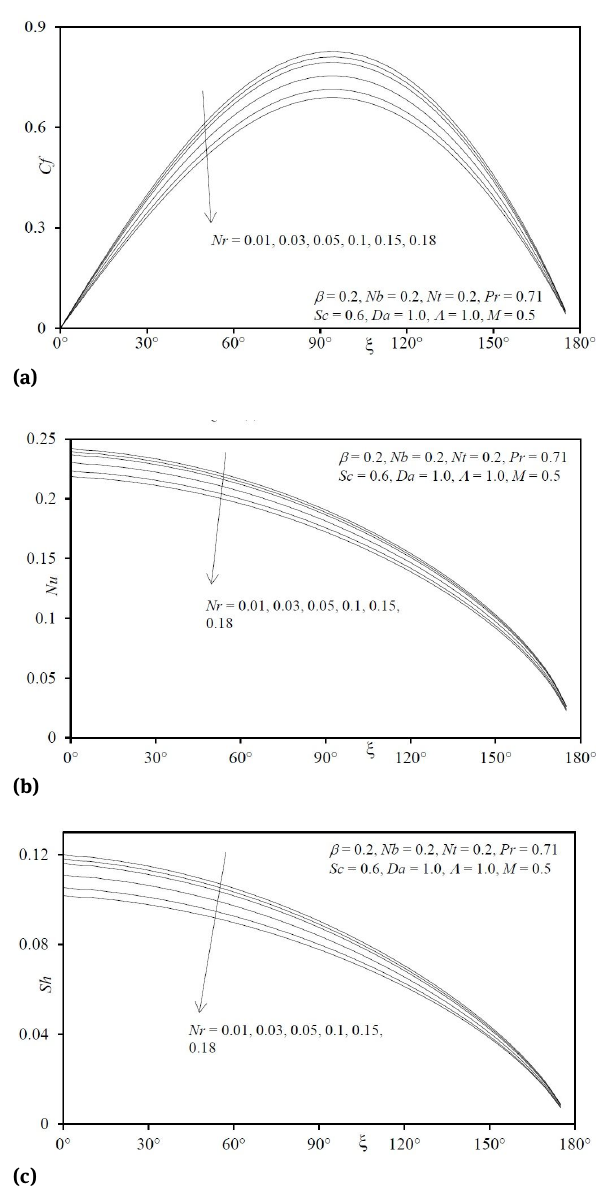
Fig. 11: (a) Influence of Nr on Skin Friction; (b) Influence of Nr on Nusselt; (c) Influence of Nb on Sherwood